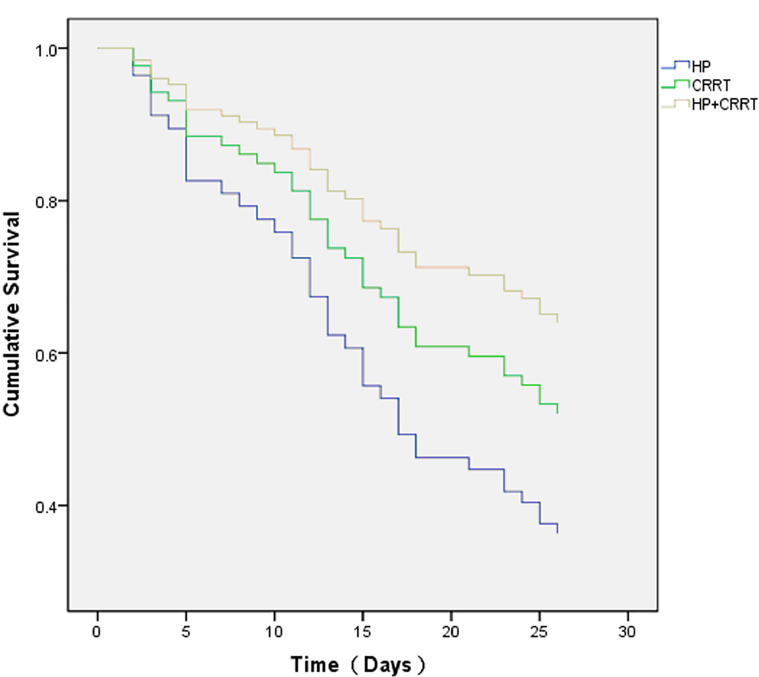
Fig 4. Comparison of survival curves for three treatments. Hemoperfusion(HP), continuous renal replacement therapy (CRRT), and combinedtreatment (HP+CRRT) in patients with plasma paraquat levels between1,000 and 5,000 ng/mL. The chi-squared value betweenHP and CRRT was 1.466; p > 0.05.The chi- squaredvalue betweenHP and HP+CRRT was 2.276; p < 0.05.